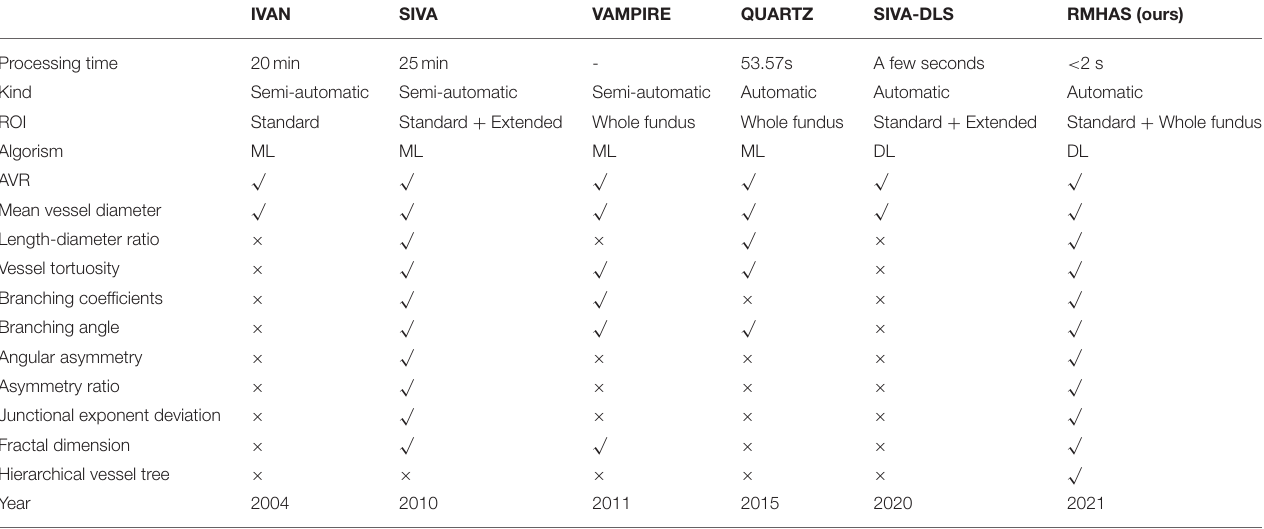
TABLE 6 | Comparison of different algorithms and software for retinal vessel analysis. IVAN Processing time